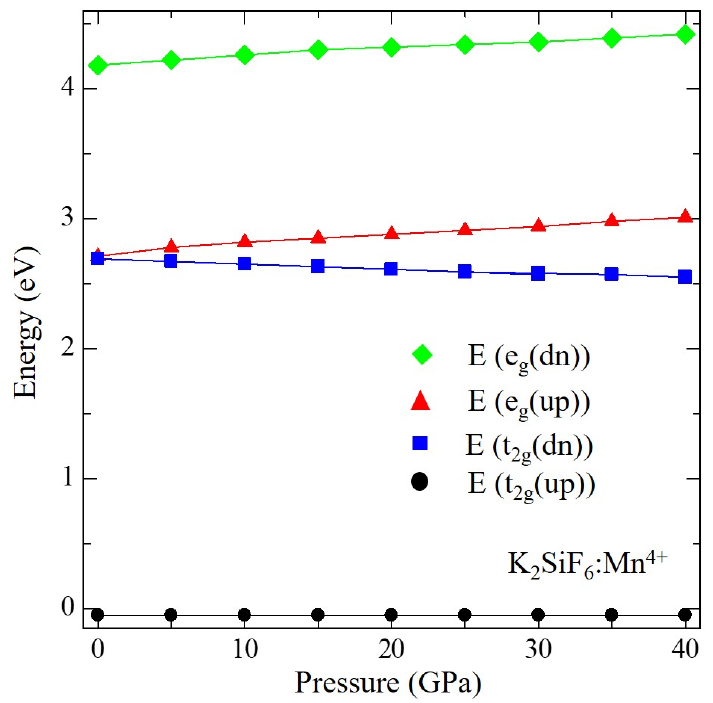
Figure 6. Calculated energy levels of the t 2g -up, t 2g -down, e g -up and e g -down states of Mn 4+ -doped K 2 SiF 6 as a function of pressure. Table 4. Comparison of the experimental and calculated 2 E → 4 A 2 emission transition energy and 10 Dq for the Mn 4+ -doped K 2 SiF 6 at different